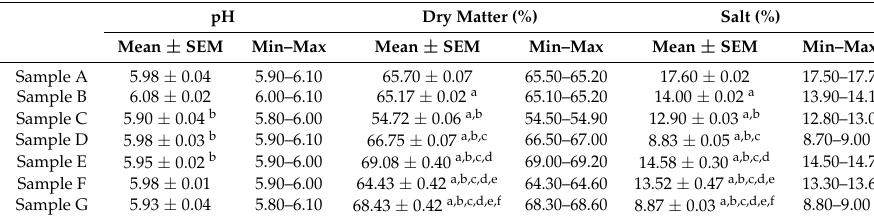
Table 3. Physicochemical analysis